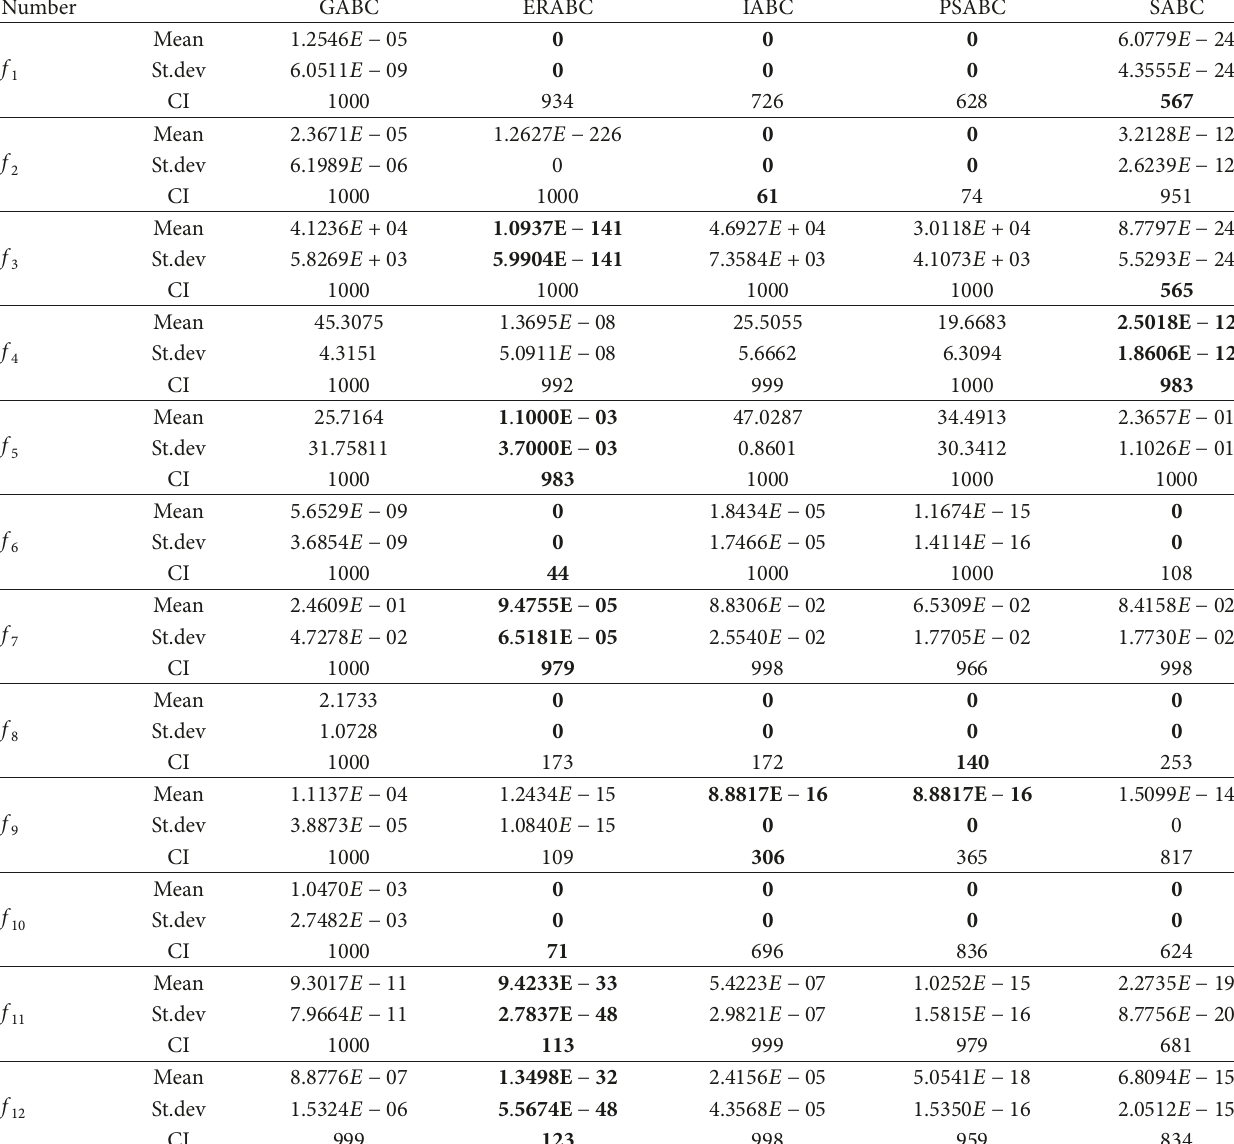
Table 4: Performance comparison of GABC, ERABC, IABC, PSABC, and SABC on test functions f 1 – f 12 (Dim = 50).